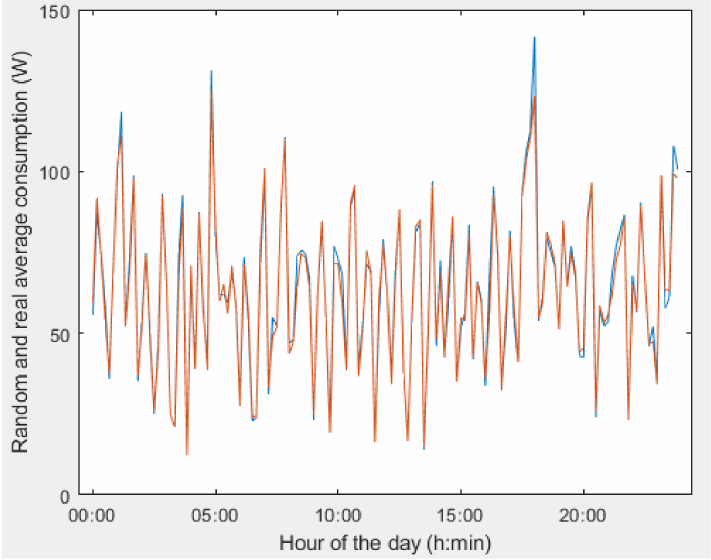
Figure 9. Random (blue) and real (orange) average consumption of the refrigerator during